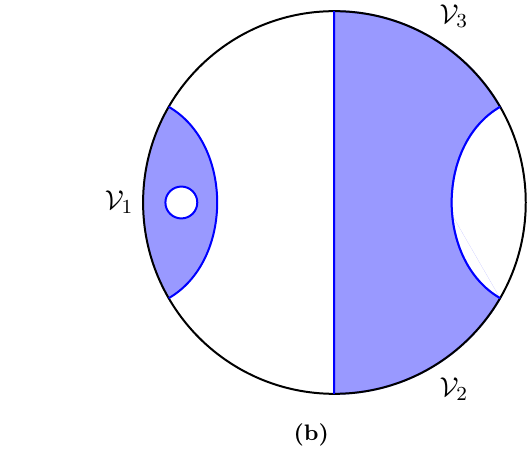
to V and the component containing V 2 3 ,